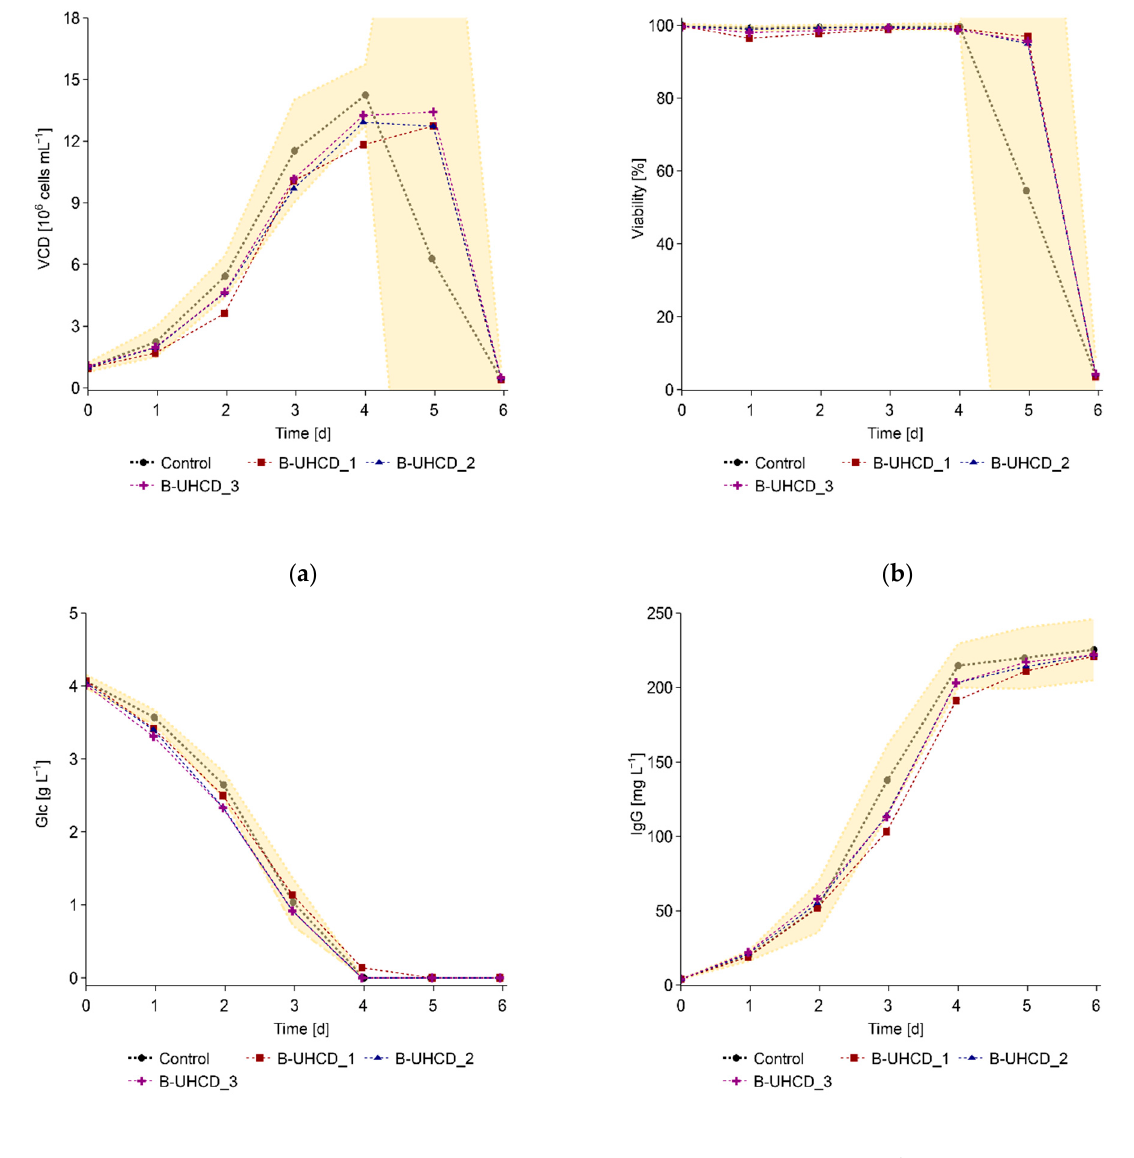
Figure 7. Course of ( a ) VCD, ( b ) viability ( c ) glucose (Glc), and ( d ) IgG concentration during the batch experiments inoculated directly from the UHCD-WCB (nomenclature: B = Batch, UHCD = inoculated from UHCD-WCB). Control: batch experiments inoculated directly from cryovials containing lower VCDs (15 × 10 6 cells mL − 1 , n = 3).